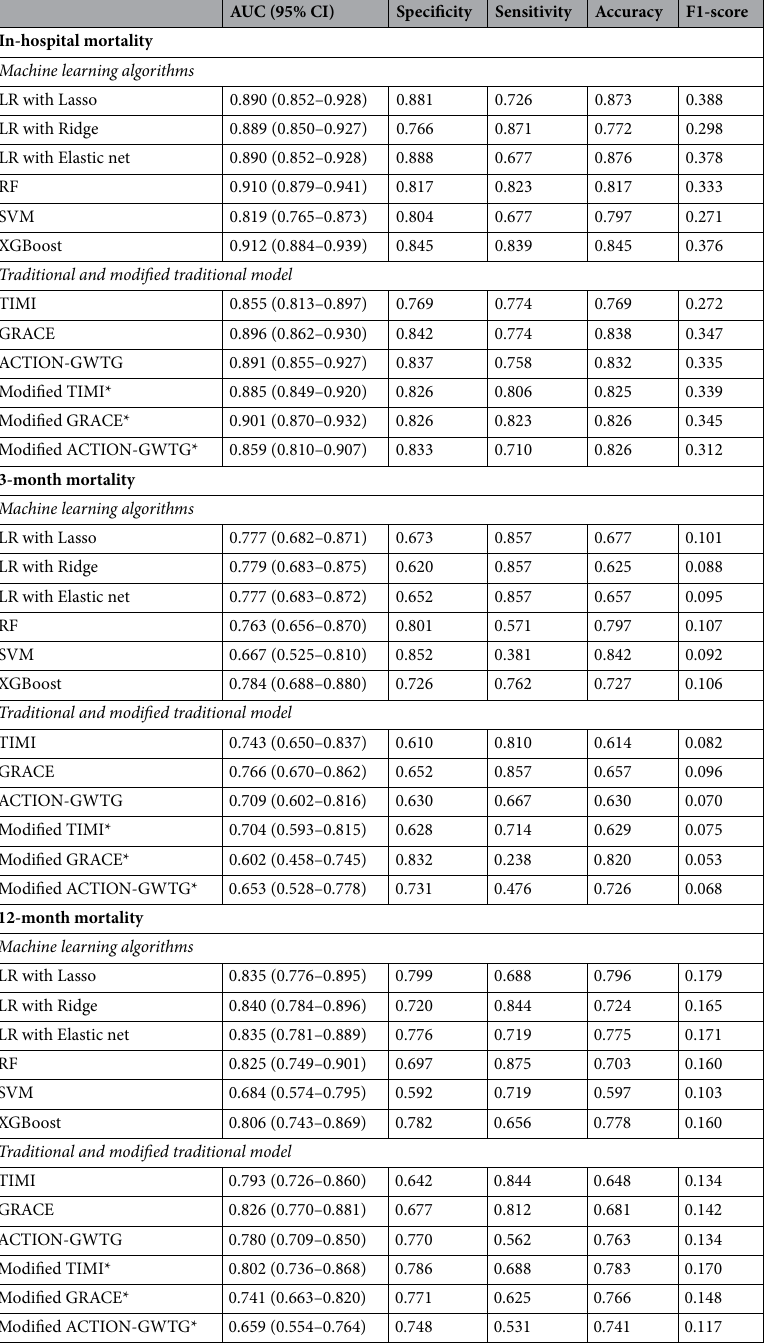
Table 2. Performance in the mortality prediction models in ST-segment elevation myocardial infarction using the traditional features. AUC, area under the receiver operating characteristic curve; CI, confidential interval; LR, Logistic regression; Lasso, L1 penalty; Ridge, L2 penalty; Elastic net, Elastic net penalty; RF, Random Forest; SVM, Support Vector Machine; XGBoost, Extreme Gradient Boosting; Thrombolysis in myocardial infarction, TIMI; Global registry of acute coronary events, GRACE; Acute coronary treatment and intervention outcomes network—Get With The Guidelines, ACTION-GWTG. *Traditional models were modified using the recalculated parameters for TIMI, GRACE, and